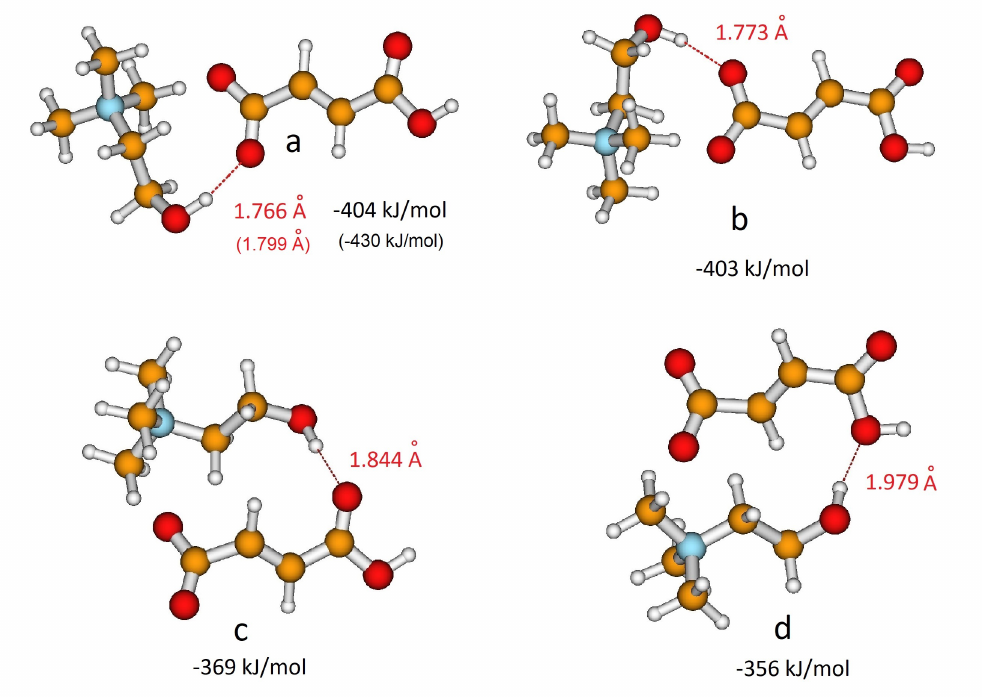
Figure 2. Different coordination structures, ( a ), ( b ), ( c ) and ( d ), of H-fumarate anion and choline cation. Hydrogen bonding distance and binding energy are evaluated from B3LYP/6–311++G** calculations. Values in parentheses are obtained from MP2/6–311++G**